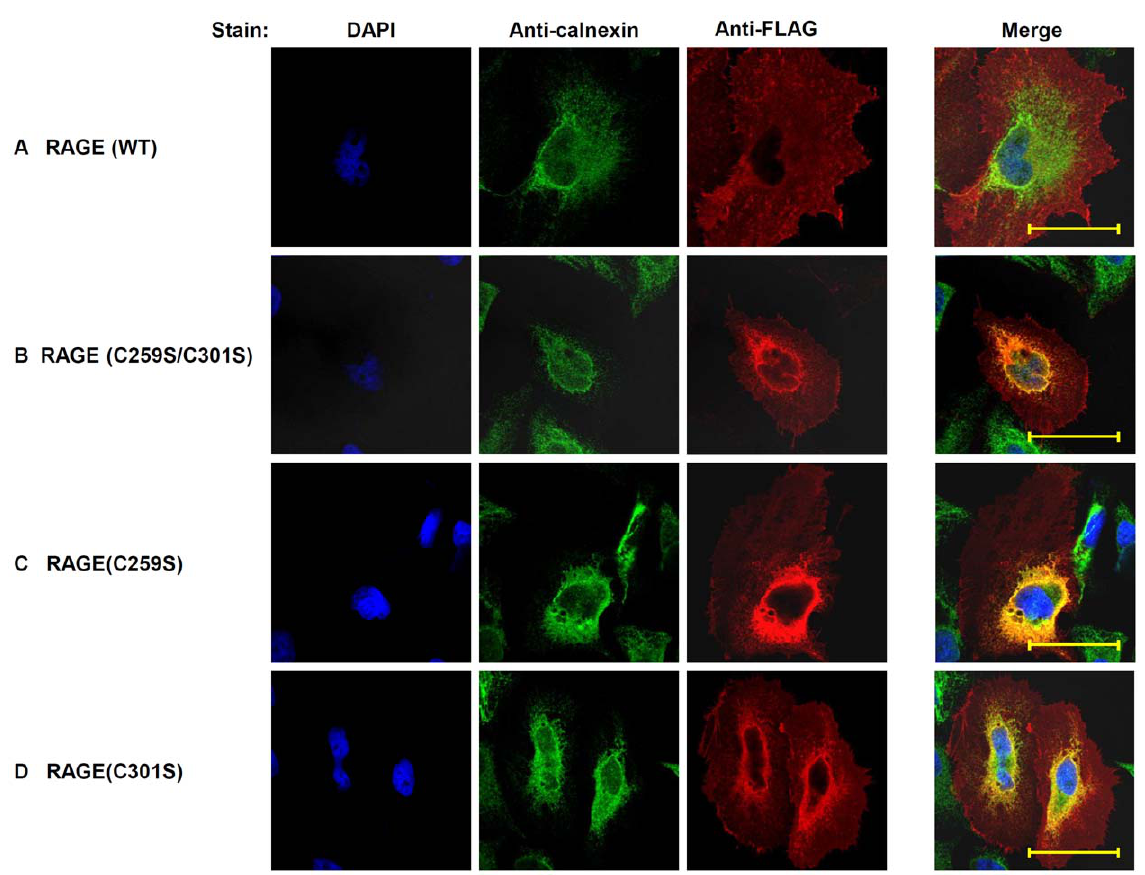
Figure 4. Intracellular localization of RAGE and RAGE cysteine-to-serine mutants. FLAG-tagged RAGE and mutants were transfected to HeLa cells and intracellular immunocytochemistry was performed. Scale bars: 50 m M for all images. ( A ) Localization of RAGE (WT). Blue: DAPI (stain nucleus); green: anti-calnexin (as the ER marker); red: anti-FLAG. Co-localization is demonstrated by the yellow color of the merged image. ( B ) Co- localization of RAGE (C259S/C301S) with the ER marker calnexin. ( C ) Co-localization of RAGE (C259S) with calnexin. ( D ) Co-localization of RAGE (C301S) with calnexin.